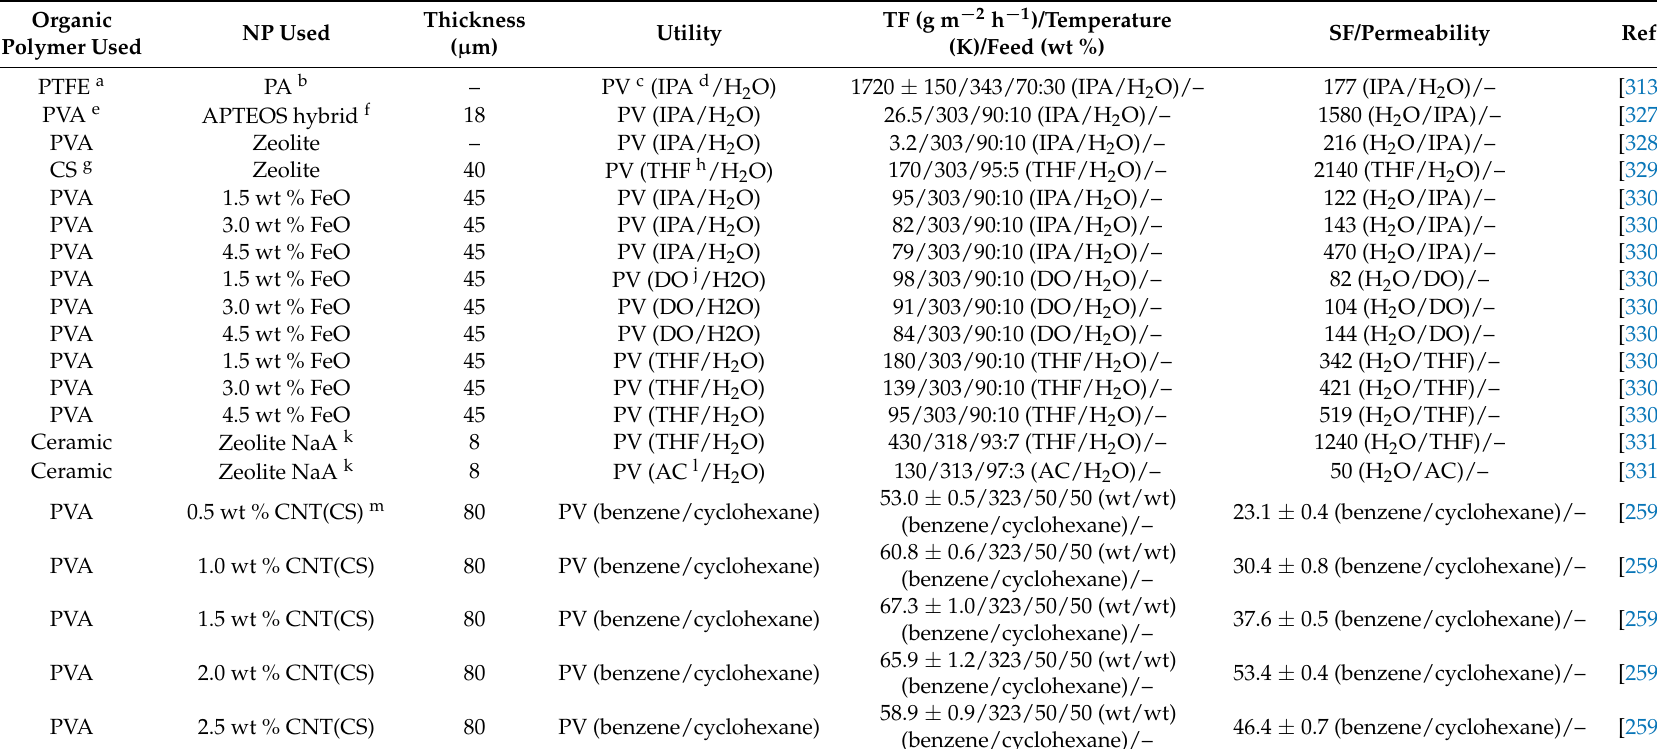
Table 2. Use of NCMs, synthesized through interfacial polymerization, for the